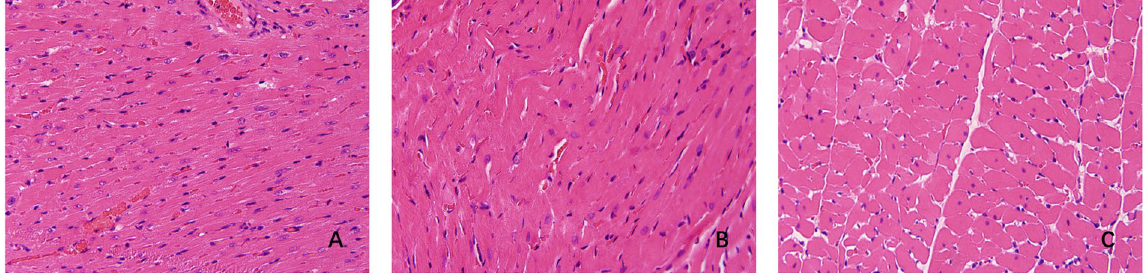
Figure 3. Histological changes of the rat hearts. ( A ) Control, ( B ) LS and ( C ) SS groups. ( A ) Normal structure of myocardial tissue (magnification: x400). ( B ) Swelling and disorganized muscle fibers (magnification, x400). ( C ) Mild swelling and orderly arrangement myocardial fibers (magnification, x400). LS, low selenium; SS, selenium